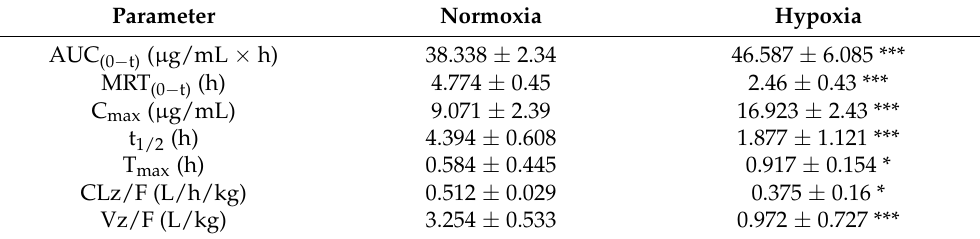
Table 6. Pharmacokinetic parameters of acipimox to rats with and without hypoxia ( n = 6 ).